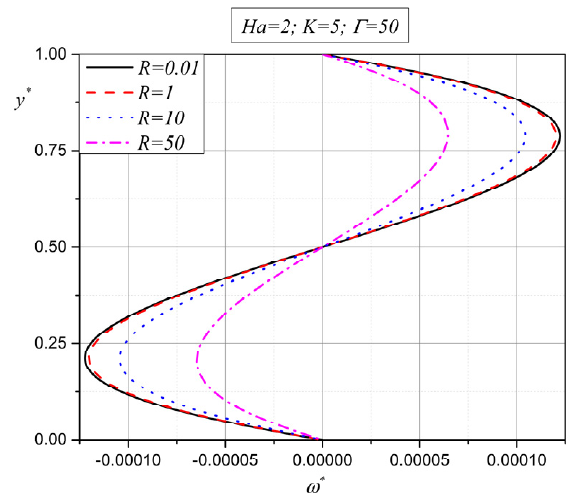
Figure 14. Microrotation vector ω * as a function of porosity parameter R .